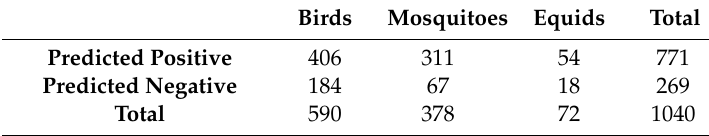
Table 4. Classification matrix for positives only, grouped by animal category and model